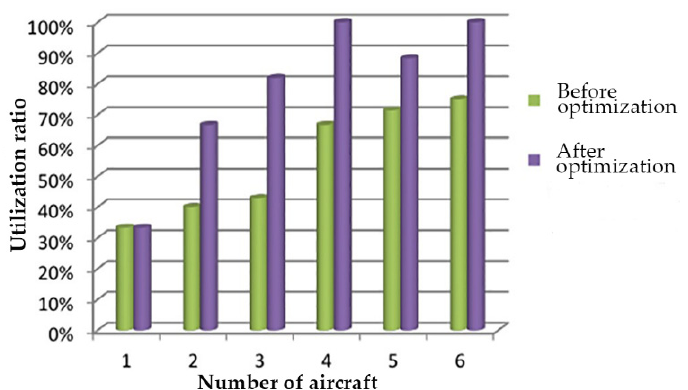
Figure 8. The relationship between the average utilization rate of oxygenation refilling trucks and the number of support aircraft before and after optimization.